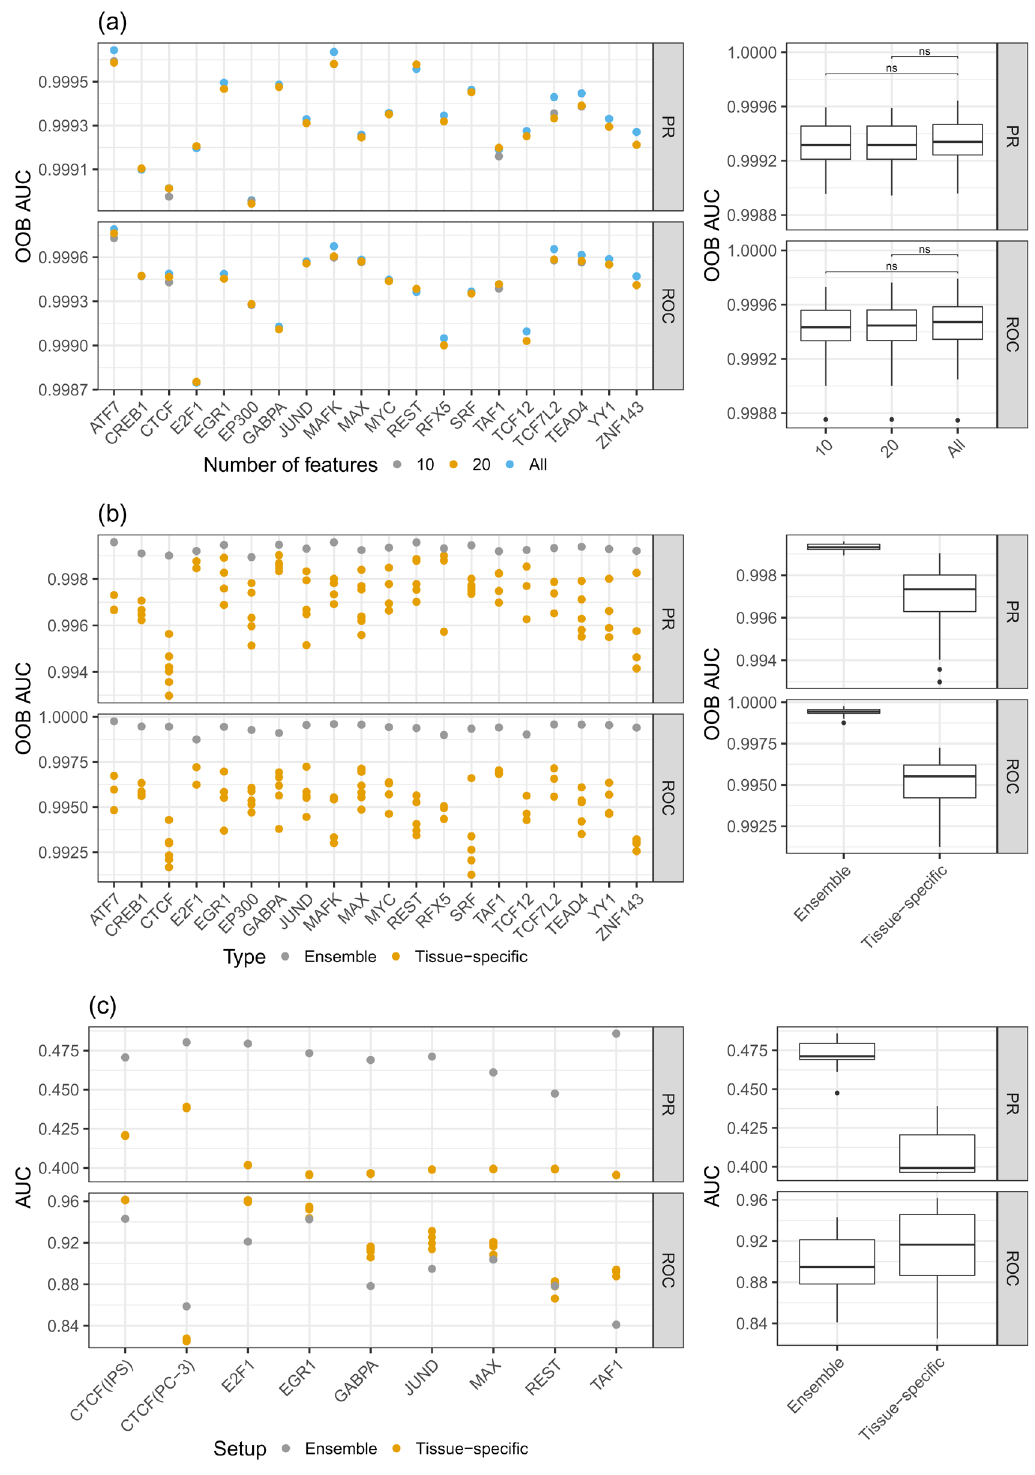
Figure 3. a ) PR-AUC and ROC-AUC for different sets of features: considering all features, the top 10, and the top 20 features. One can see that the difference in model performance between the top 20 and all feature cases is only marginal. b ) Comparison of the out of bag (OOB) error between ensemble models and tissue-specific random forest (RF) classifiers. The ensemble models show superior performance compared to the tissue-specific RF classifiers. c ) PR-AUC and ROC-AUC computed on unseen test data for ensemble and tissue-specific RF classifiers. Due to the imbalanced nature of the test data, the ROC-AUC values are overly optimistic, as they are biased by the numerous unbound sites. However, the PR-AUC represents a more realistic view on the actual performance of the models. Note that the scale of the y-axes are different for the